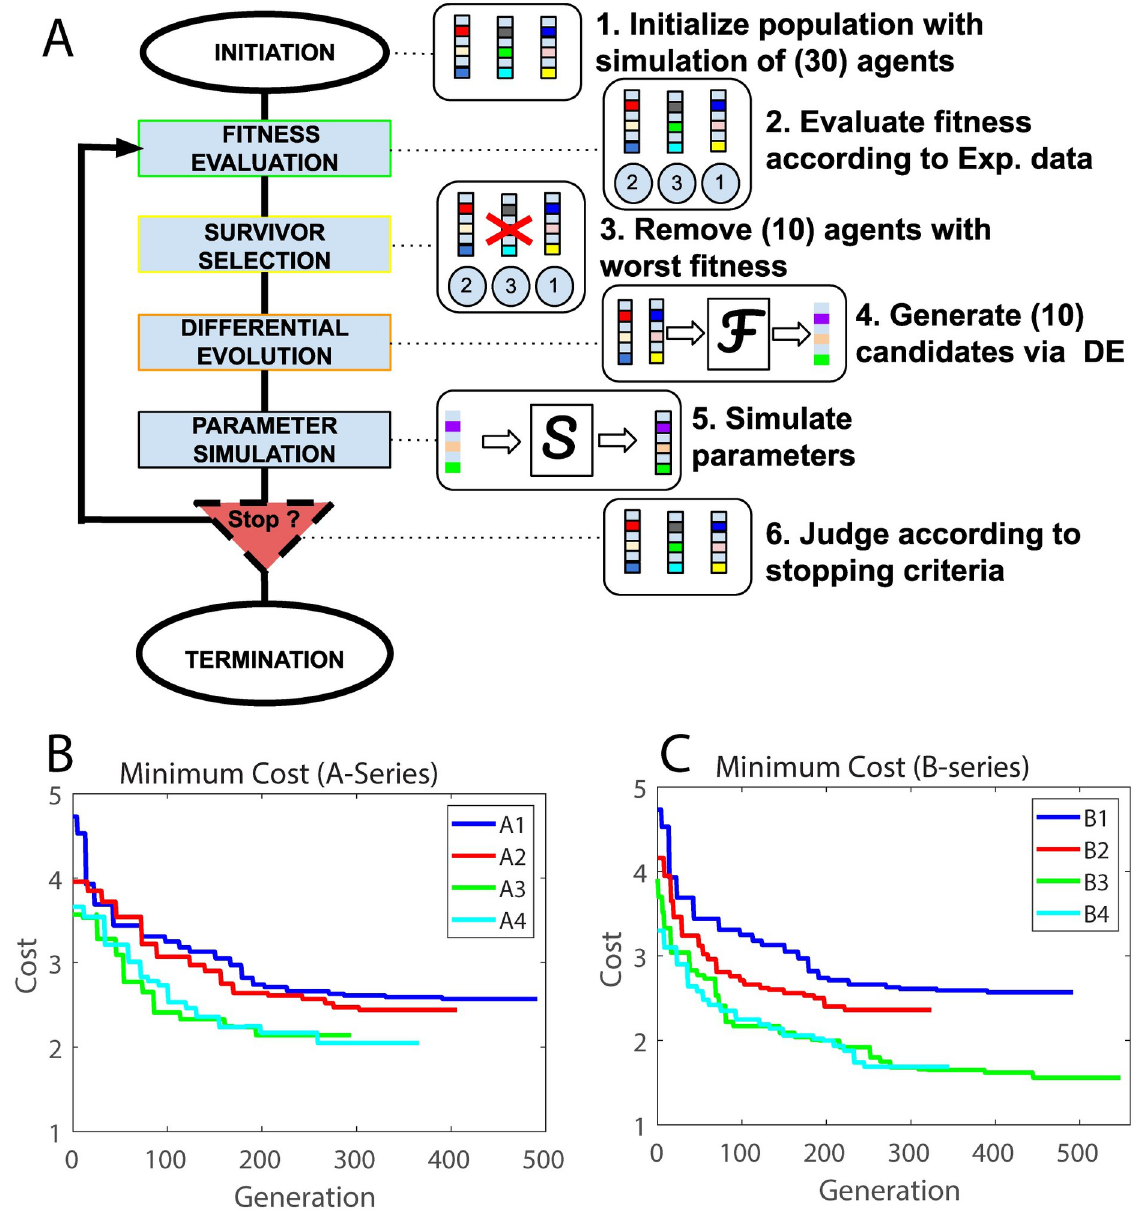
Fig 11. Parameter search fine-tuned through Differential Evolution algorithm. A). Evolutionary algorithm procedure, differential evolution, was used to optimize model parameters. For each generation, 10 agents (parameter sets) with the highest cost function from the population of 30, were chosen for replacement. Algorithm was repeated until stopping criteria of 100 generations without change in lowest cost function value across the population was met. B,C) Example optimization cost of lowest cost parameters across the population for each generation in the A-series (B) and B-series (C). Population A1/B1, A2/B2, A3/B3 and A4/B4 were optimized to experimental data from the 0%, 2%, 4% and 6% anesthetic cases, respectively. The optimizations for A1 and B1 were identical. In the A-series (A2-A4), P were optimized and in the B-Series (B2-B4), P NDMA , P GABA , g Ks were